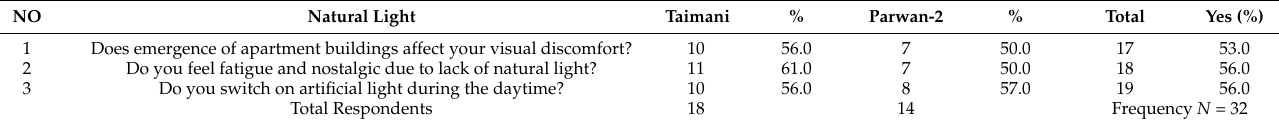
Table 7. Responses of Residents to Natural